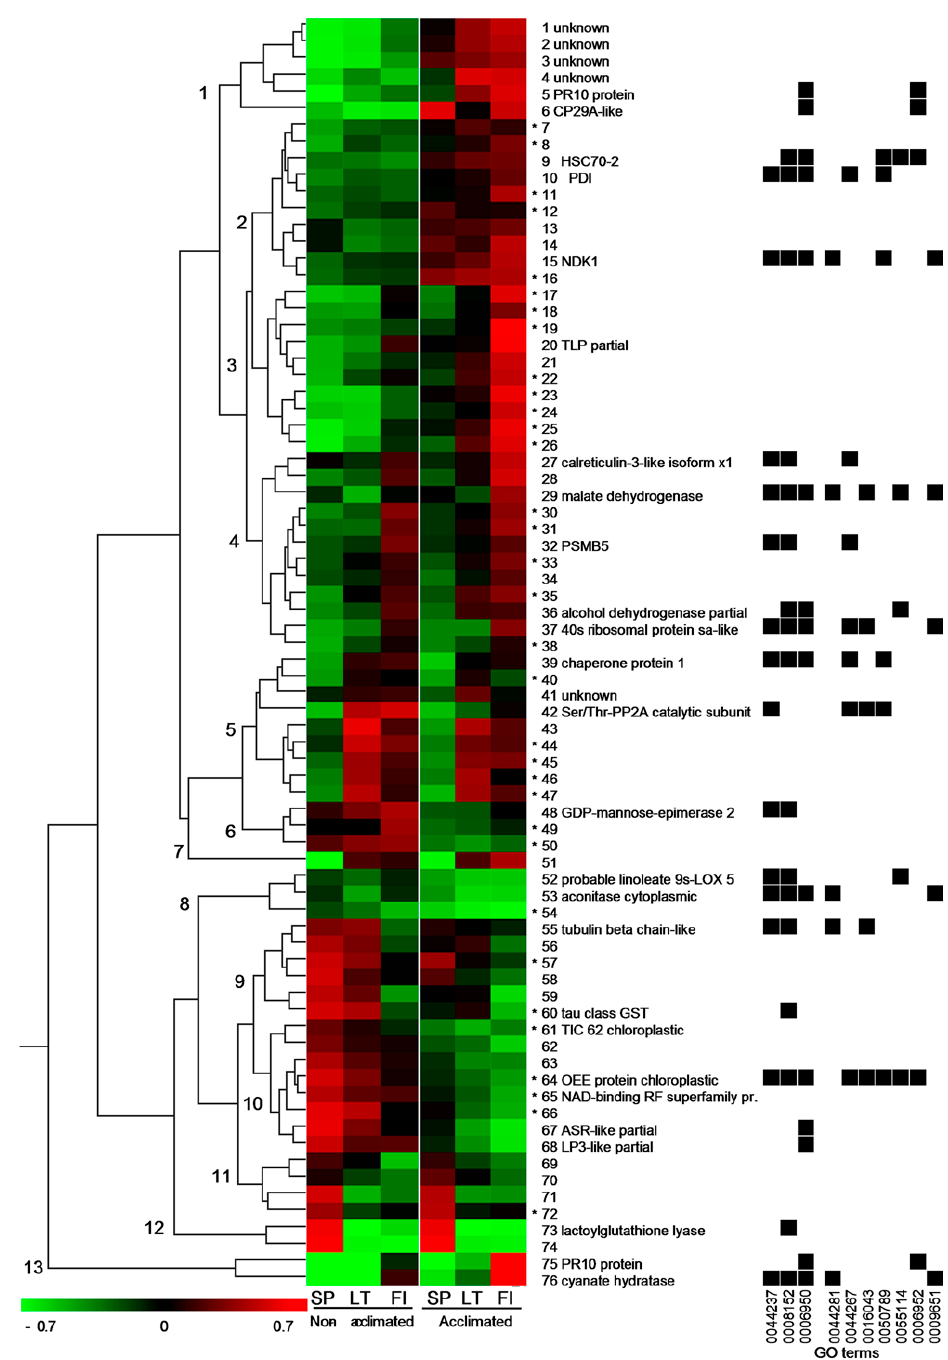
Figure 4. Cluster analysis of abundance of the 76 protein spots differentially expressed in needles of the Scots pine seedlings among the three populations and/or under cold acclimation treatment. The standardized abundance scale is show at the lower left corner. Thirteen major clusters are marked by numbers. Star indicates spots that were identified as mixtures of 2–4 proteins (listed in Table S1). GO terms associated with the identified unique protein sequences are shown on the right (the terms corresponding to the indicated numbers are listed in the Results section).